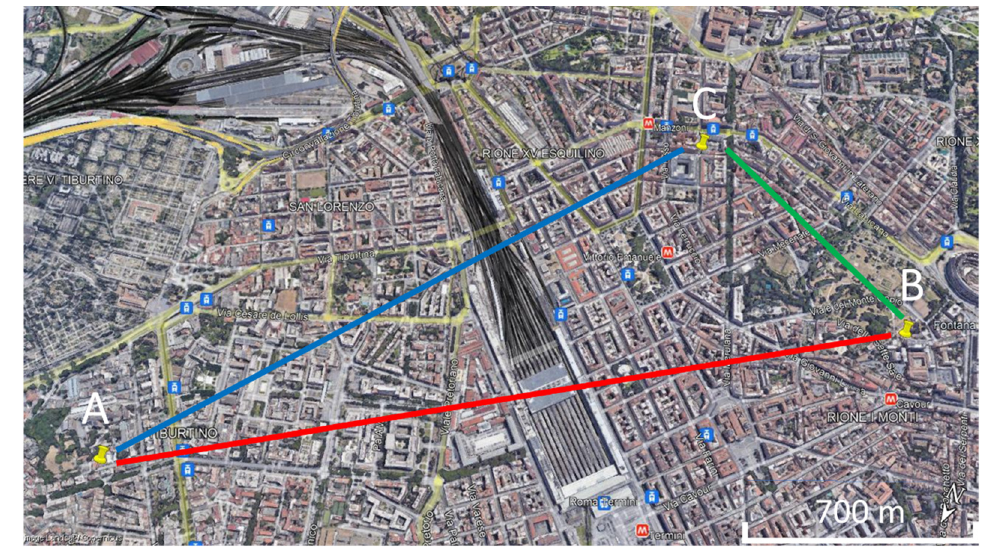
Figure 5. Location of the three departments under study from Google Earth.